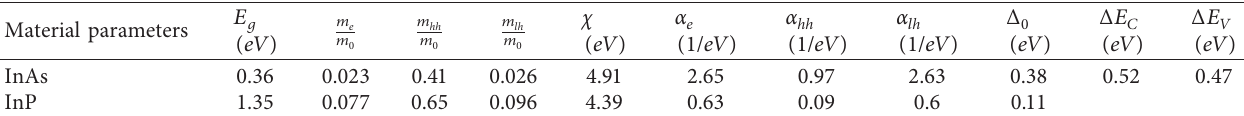
Table 2: Material parameters of InAs and InP.